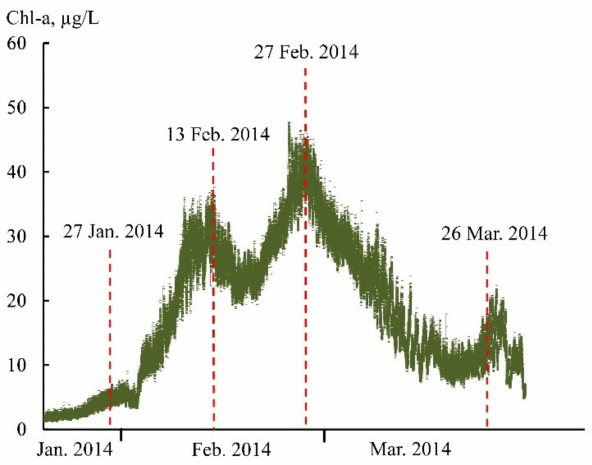
Figure 5. Long-term measurements by a bottom mooring probe WQM at St. 8 in